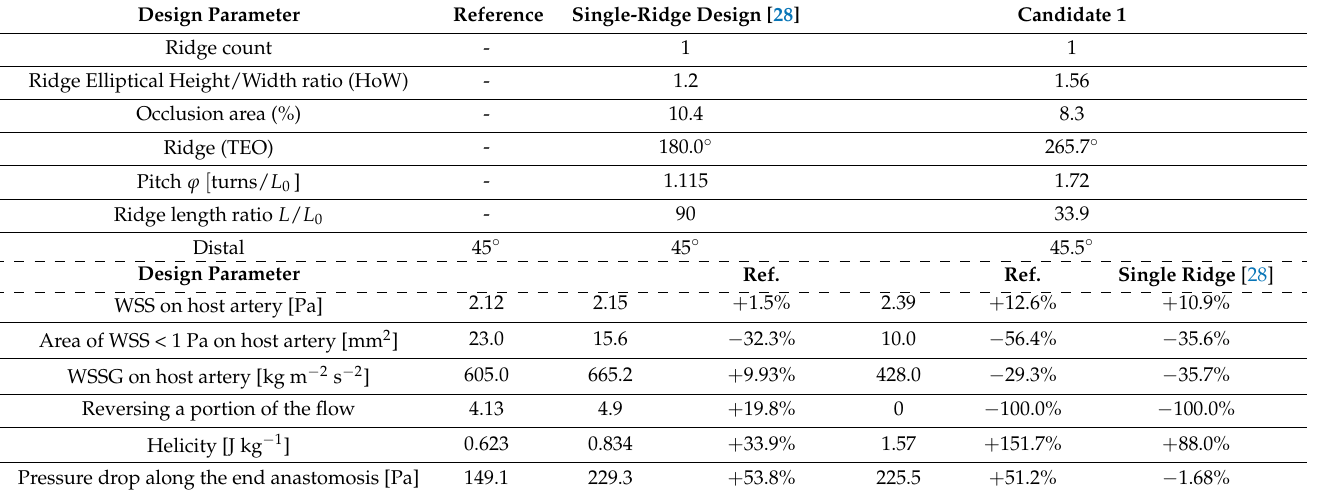
Table 5. Comparison between ‘Candidate design 1’ (taken from Table 3) and the reference solution without any ridges and a helical graft with a single ridge with dimensions similar to the Vascular Flow Technologies (VFT) graft according to